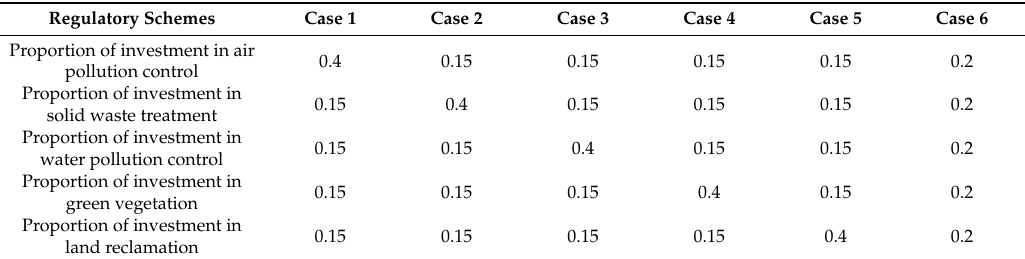
Table 2. The five regulatory